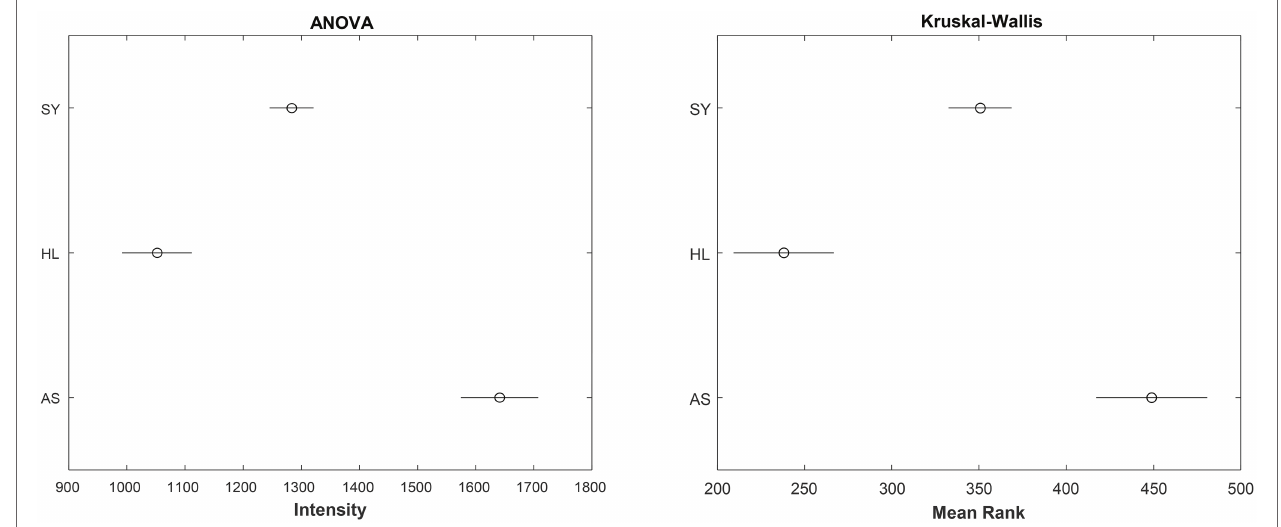
FIGURE 2 | 95% Confidence intervals for the true mean intensity (left) or mean rank of intensity (right) for the rose leaf data at the 1,610 cm − 1 band. SY - symptomatic; HL - healthy control; AS -